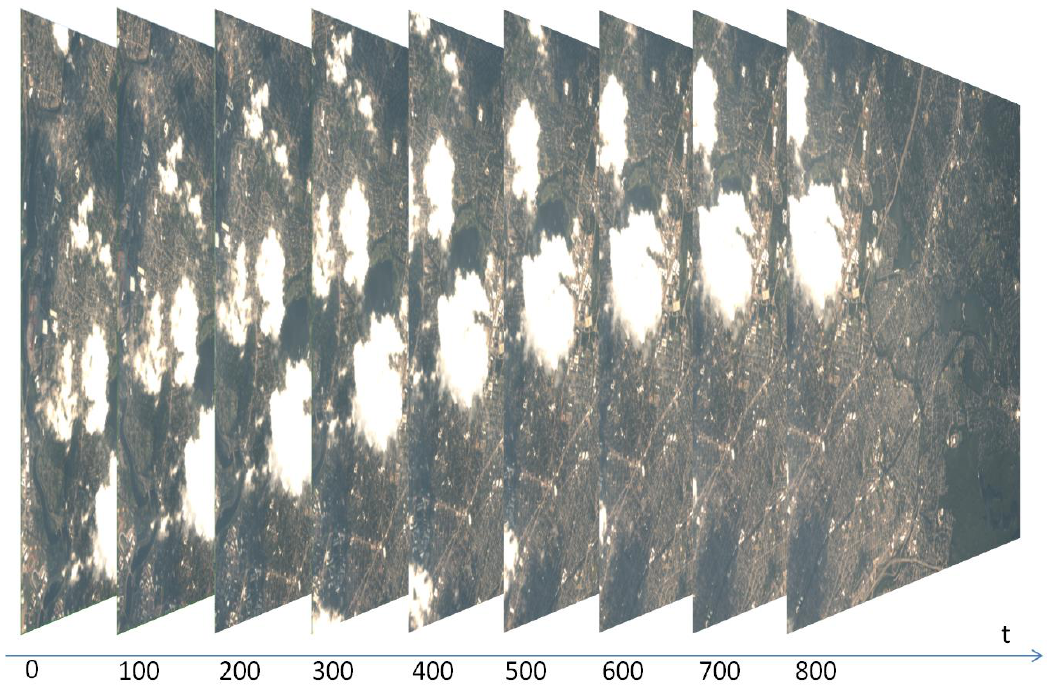
Figure 9. Simulation images.